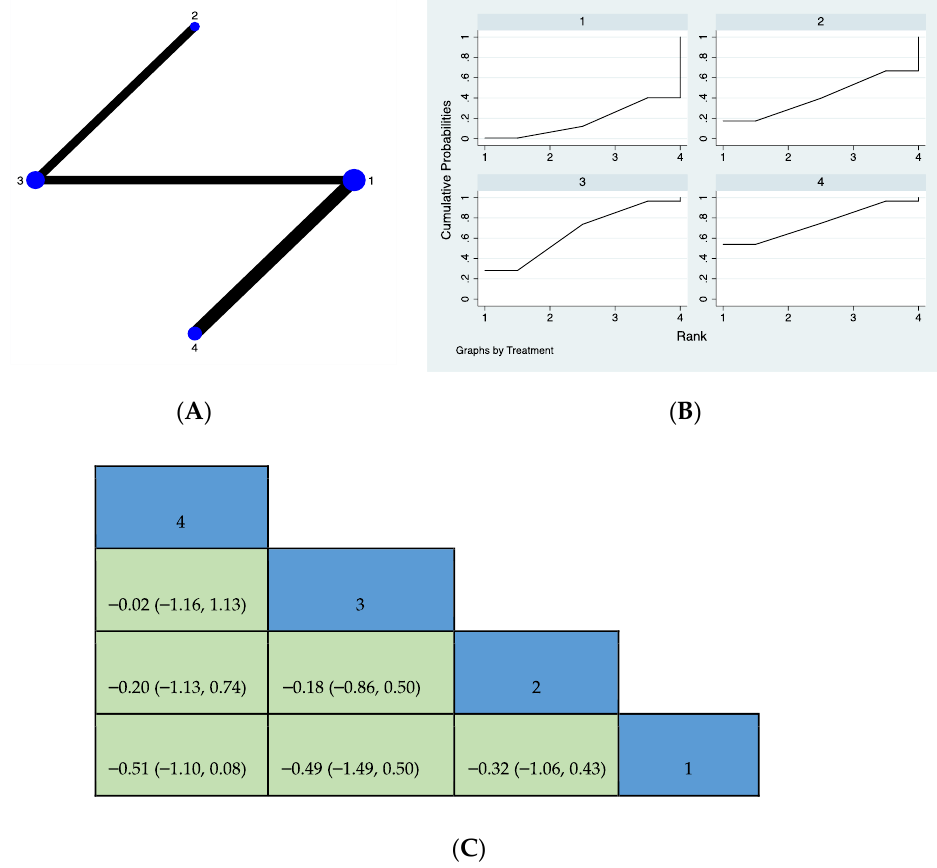
Figure 6. ( A ) NMA figure for COD; ( B ) SUCRA plot for COD; ( C ) league table of COD. 1 = control group; 2 = resistance training group; 3 = plyometric training group; 4 = plyometric + resistance + sprint + agility training group.